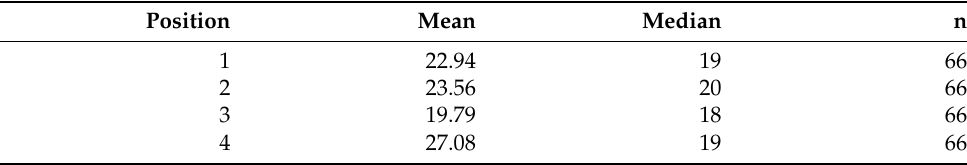
Table A5. Statistics by Position .